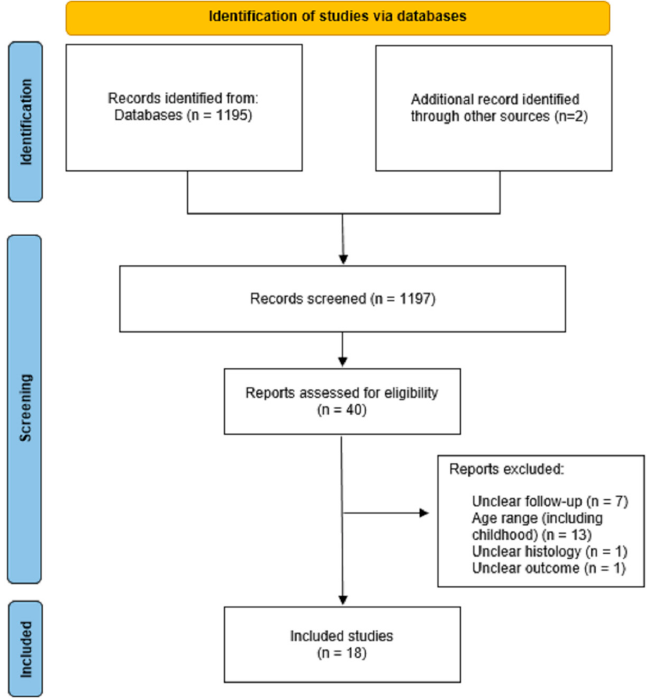
Figure 1. Flow diagram for systematic review.